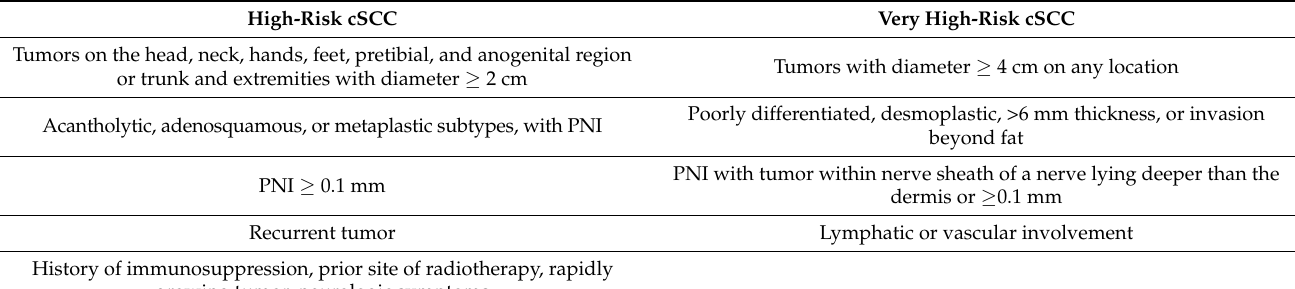
Table 1. National Comprehensive Cancer Network features of high-risk and very high-risk cutaneous squamous cell carcinoma (May 2022); PNI, perineural invasion.